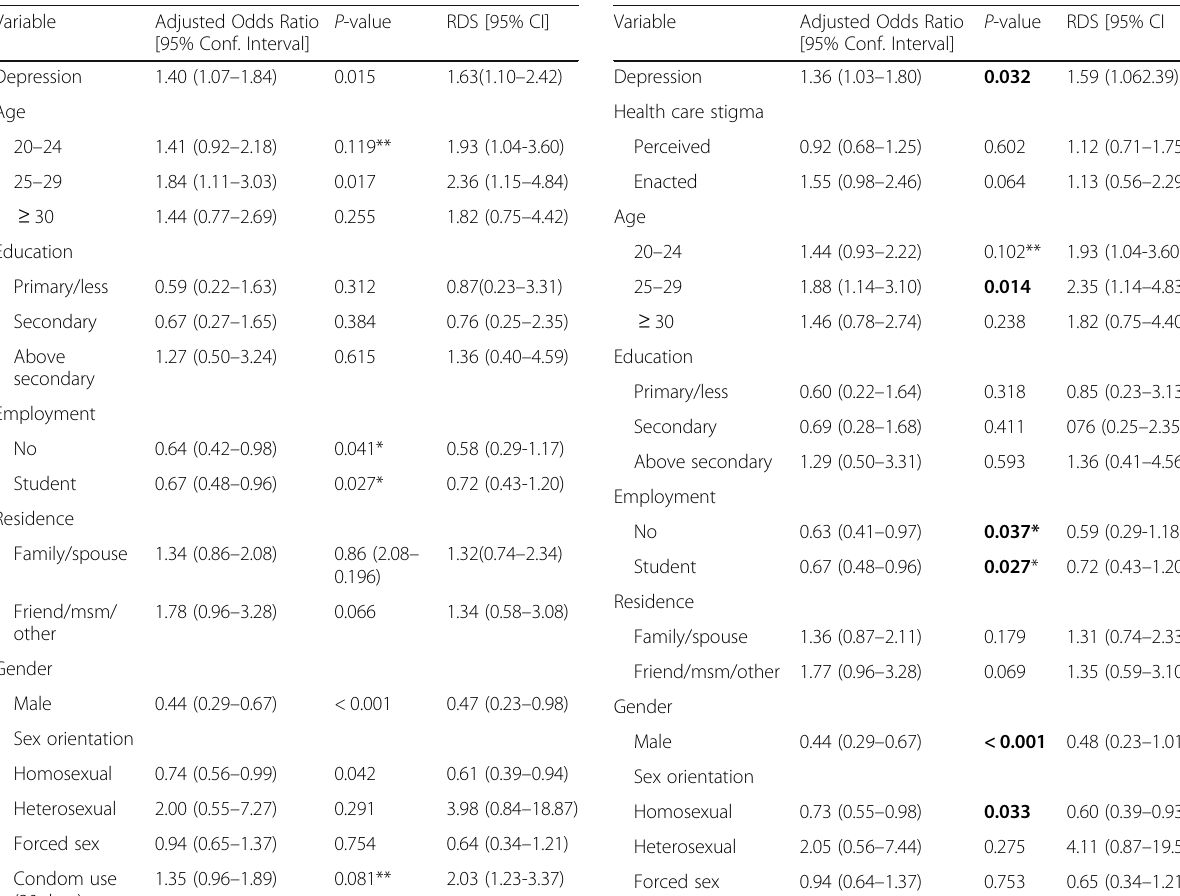
Table 4 Final multivariable model 2: adjusted associations with utilization of sexual health care services